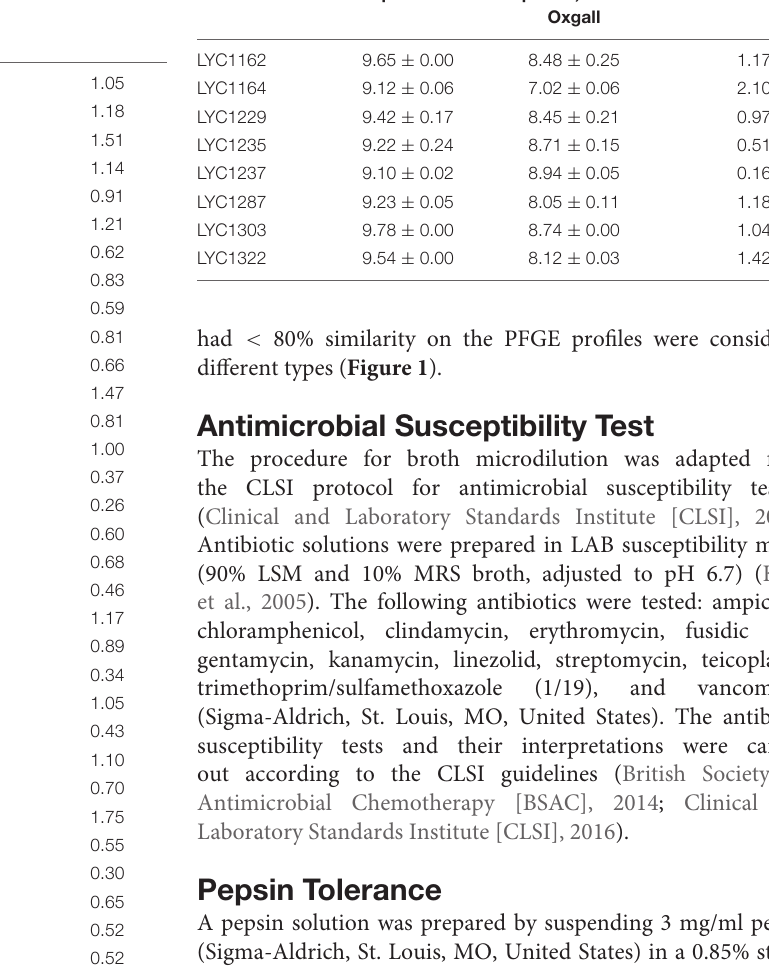
TABLE 4 | Bile salt tolerance test results for 57 Lactobacillus isolates at pH 7.3 with 0.3% Oxgall. Lactobacillus strain